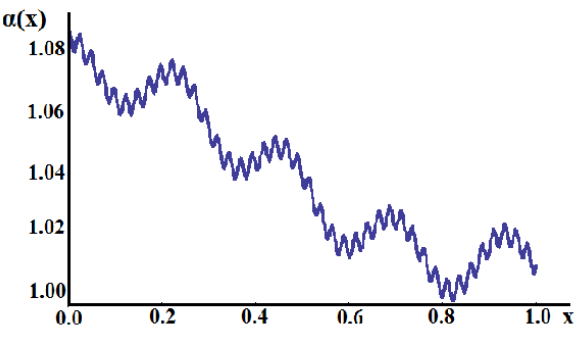
Figure 10. The (dimensionless) distribution of the cross-sectional area a ( x ). Further, the length of the bar l in the initial space becomes L in the fractional Λ -space through Equation (24). The axial force p applied at the right end of the bar corresponds to the P load in the Λ -space defined by Equation (23). In addition, Young’s modulus of Λ elasticity E corresponds to E defined by Equation